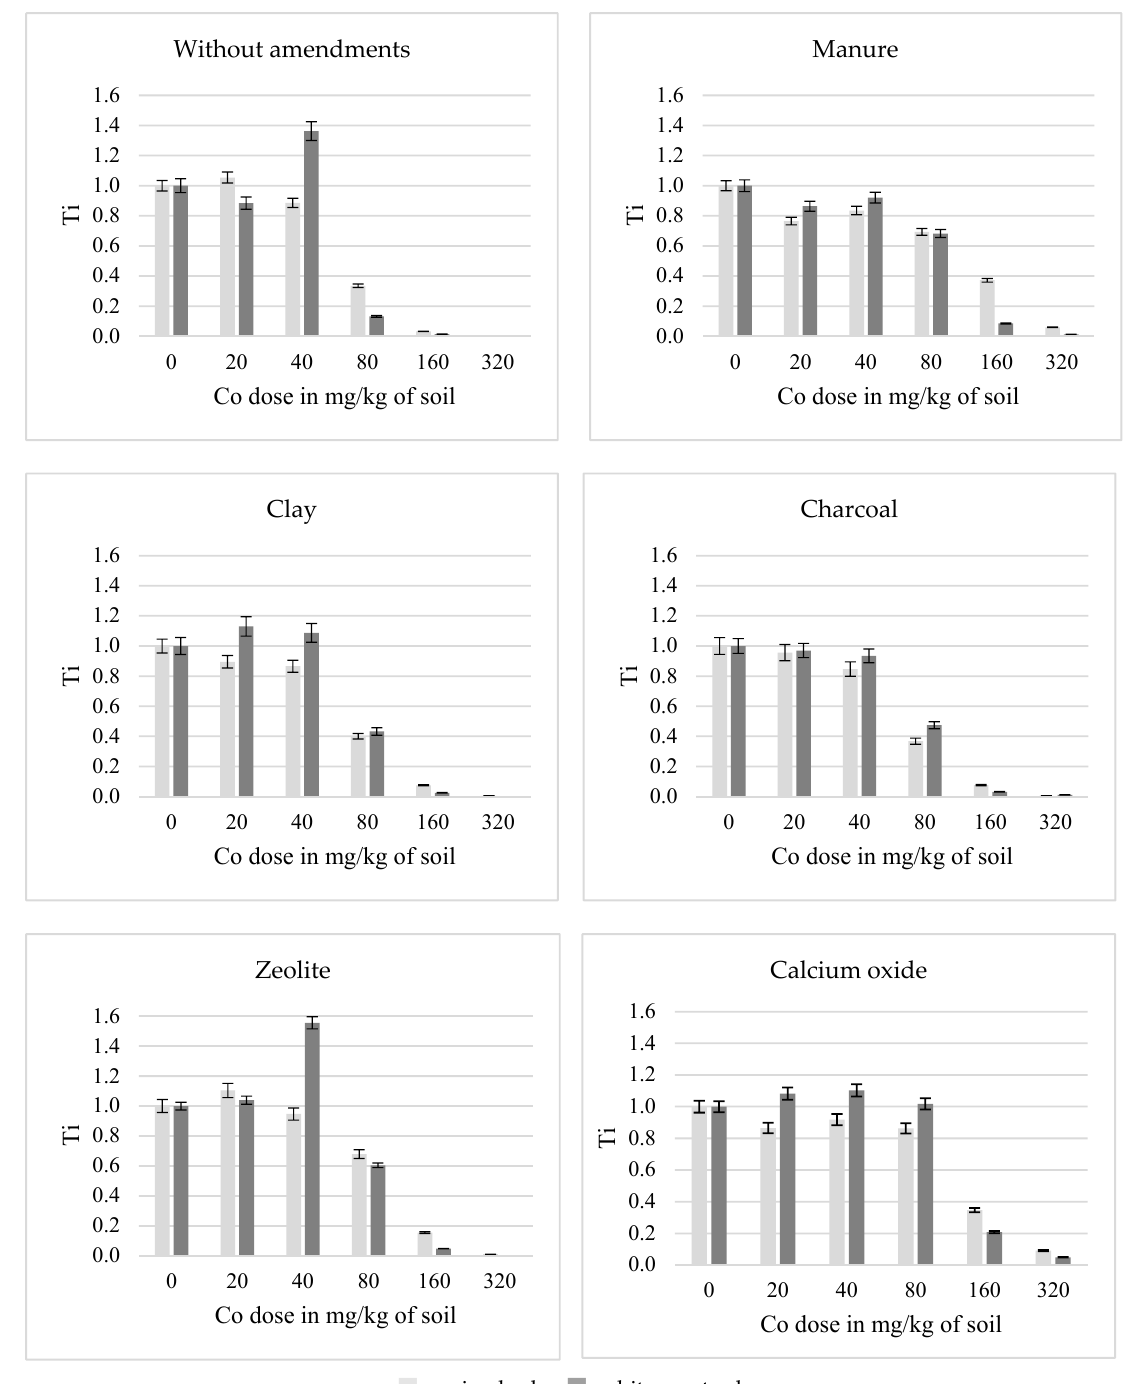
Figure 1. Tolerance index (Ti) for plants.